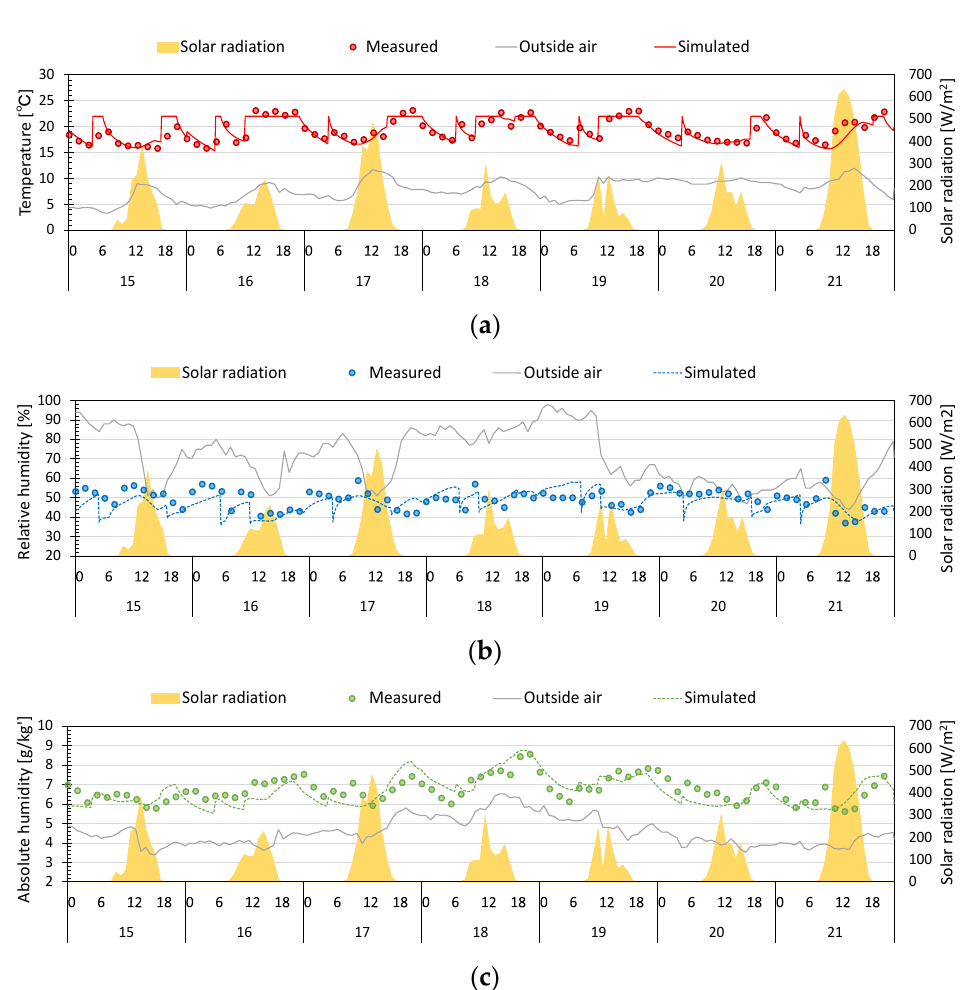
Figure 7. Comparison of measured value and simulated value: ( a ) temperature; ( b ) relative humidity; ( c ) absolute humidity.